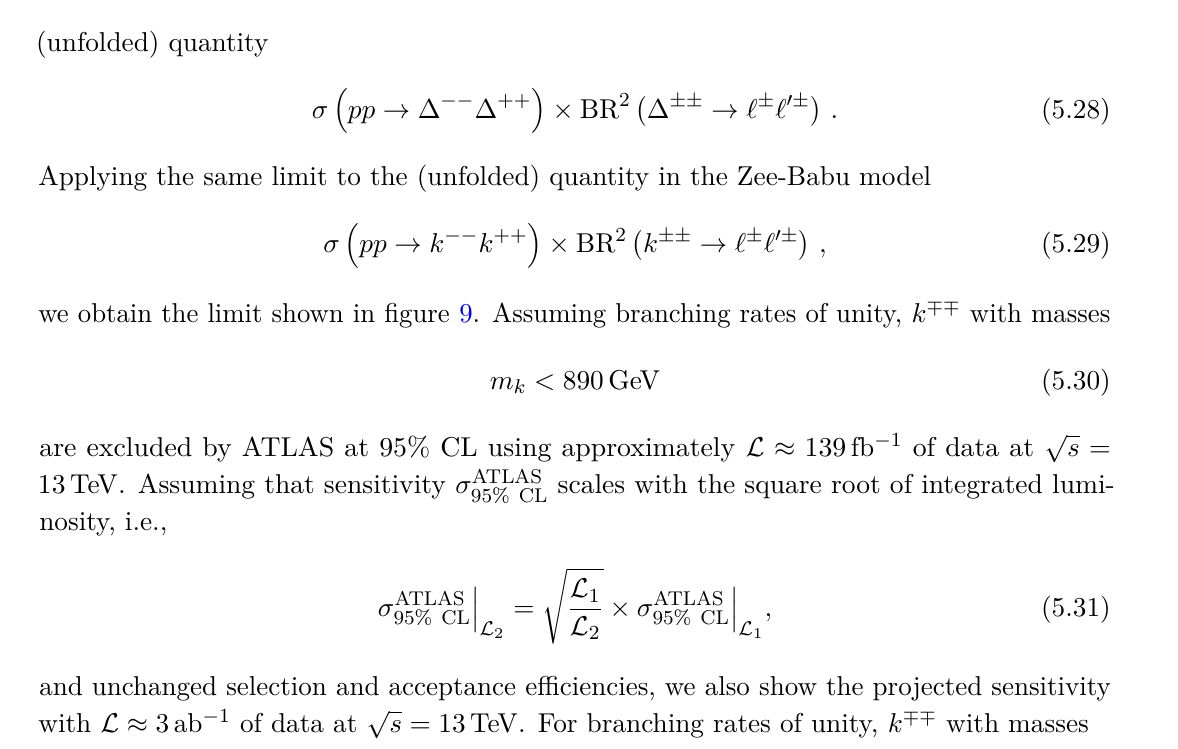
Table 4 . For representative m k (top), estimated (middle) and projected (bottom) limits on the decay rate of k ∓∓ → ‘ ∓ ‘ 0∓ set by ATLAS at 95% CL using L ≈ 139 fb − 1 [51] and L = 3 ab − 1 of